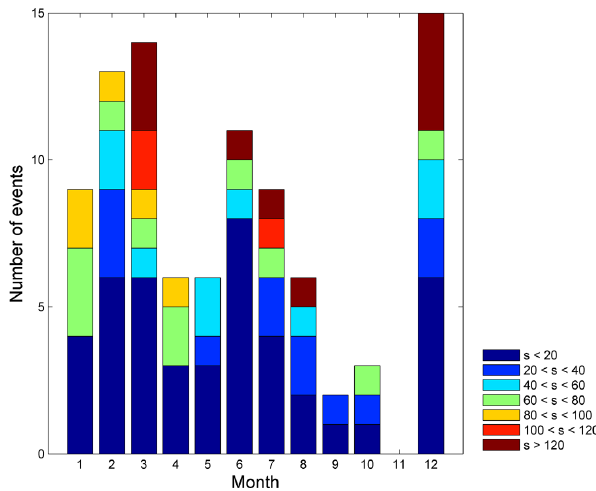
Fig. 2. Number of flood start dates per month and severity class s